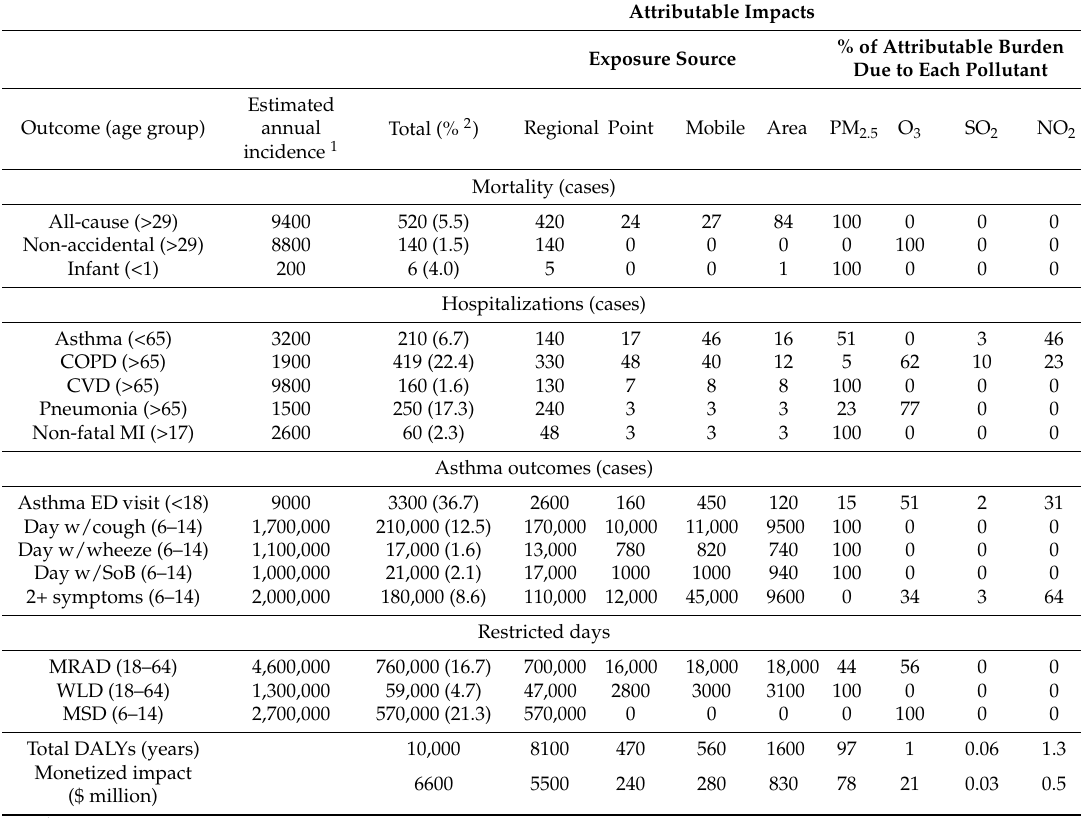
1 Estimated annual incidence rates based on block group population and ZIP code level incidence rates. 2 Percentage of the estimated annual incidence attributable to all pollutant exposures. Abbreviations: COPD: Chronic obstructive pulmonary disease; CVD: cardiovascular disease; DALYs: disability-adjusted life years; ED: emergency department; MI: myocardial infarction; MRAD: minor restricted activity day; MSD: missed